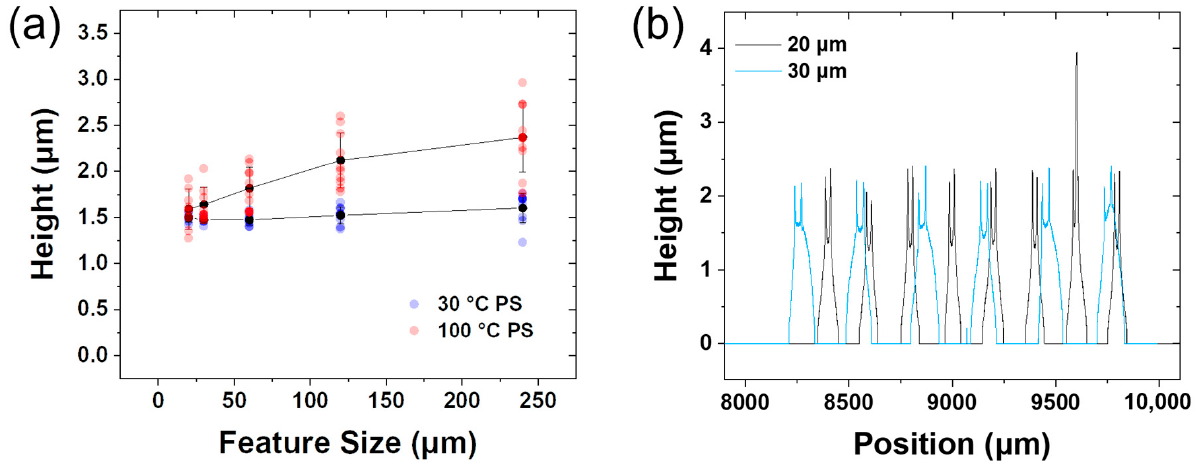
Figure 4. ( a ) Height data from the PS sprays; ( b ) Overlay of the 20 µ m and 30 µ m/9 × gap distal features for the 100 °C spray showing a lack of a positional thickness gradient.